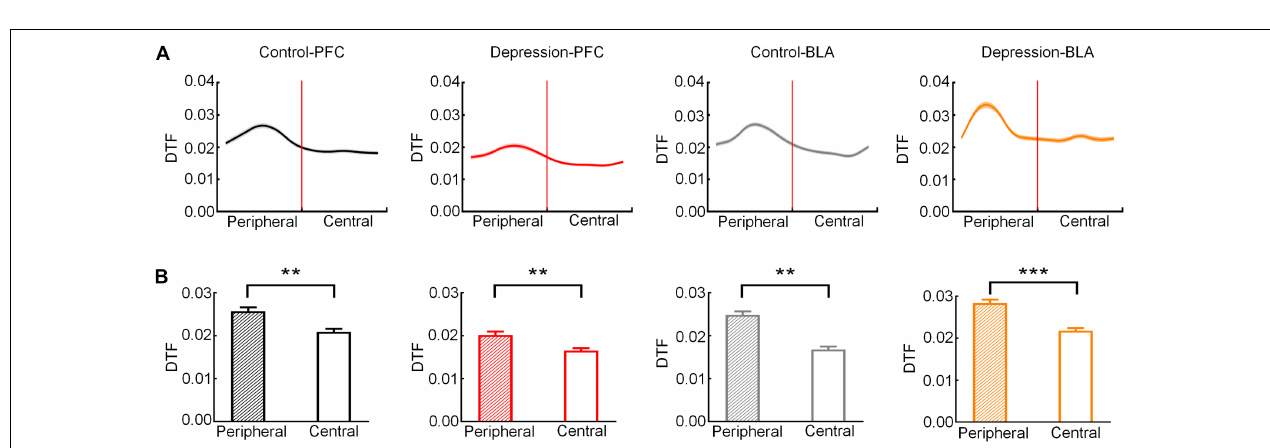
FIGURE 3 | Direct transfer function (DTF) at different frequencies of the mPFC-BLA network in the peripheral and central zone. (A) DTF in the peripheral and central zone of the control group. (B) DTF in the peripheral and central zone of the depression group. The bandwidth calculated for DTF ranged from 1 to 120 Hz. (C) DTF of the control group in different frequency bands in the peripheral and central zone. (D) DTF of the depression group in different frequency bands in the peripheral and central zone. Error bars indicate SEM. Paired sample t -test, * p < 0.05, ** p < 0.01, *** p < 0.001.